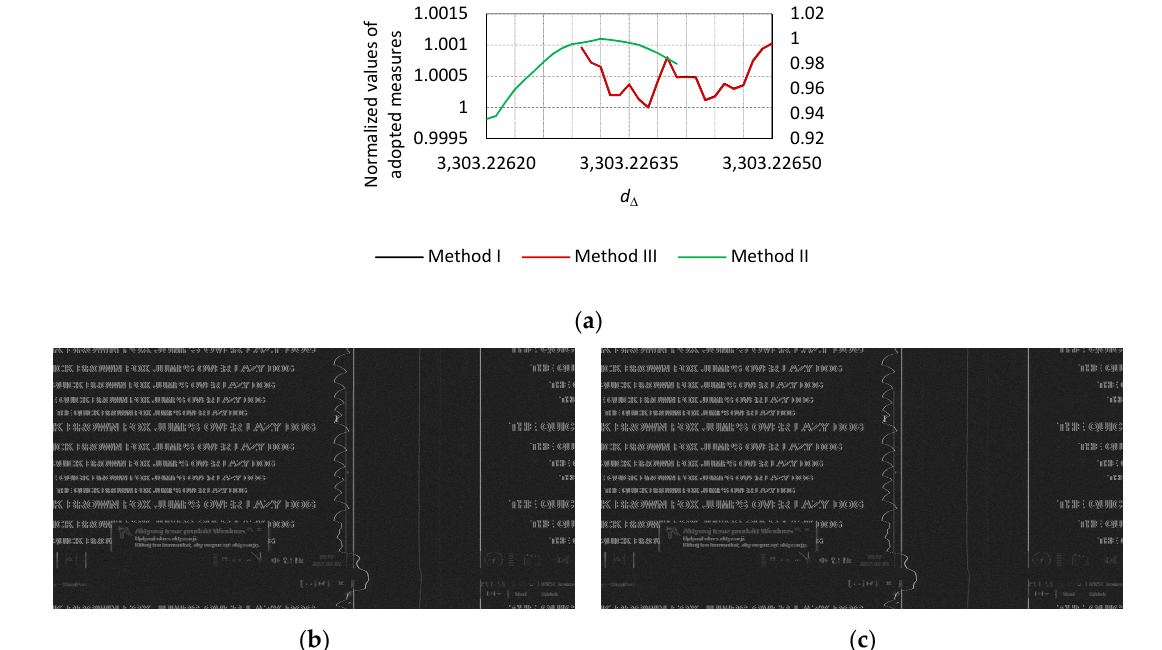
Figure 32. ( a ) The normalized values of the adopted measures (method I, II and III) calculated in domain of image line length d ∆ for the accuracy ∆ = 0.00001 (for the original image shown in Figure 7e) and images reconstructed on the basis of the recorded revealing emission signals at frequency f o = 450 MHz (receiving bandwidth BW = 50 MHz, accuracy ∆ = 0.00001), ( b ) for estimated line length d ∆ = 3303.22632 and ( c ) for estimated line length d ∆ = 3303.22637 —multiple of image summation 𝑆𝑢𝑚 (cid:3014)(cid:3021)(cid:3013) = 15 , the source of revealing signal emission—display monitor, VGA standard.